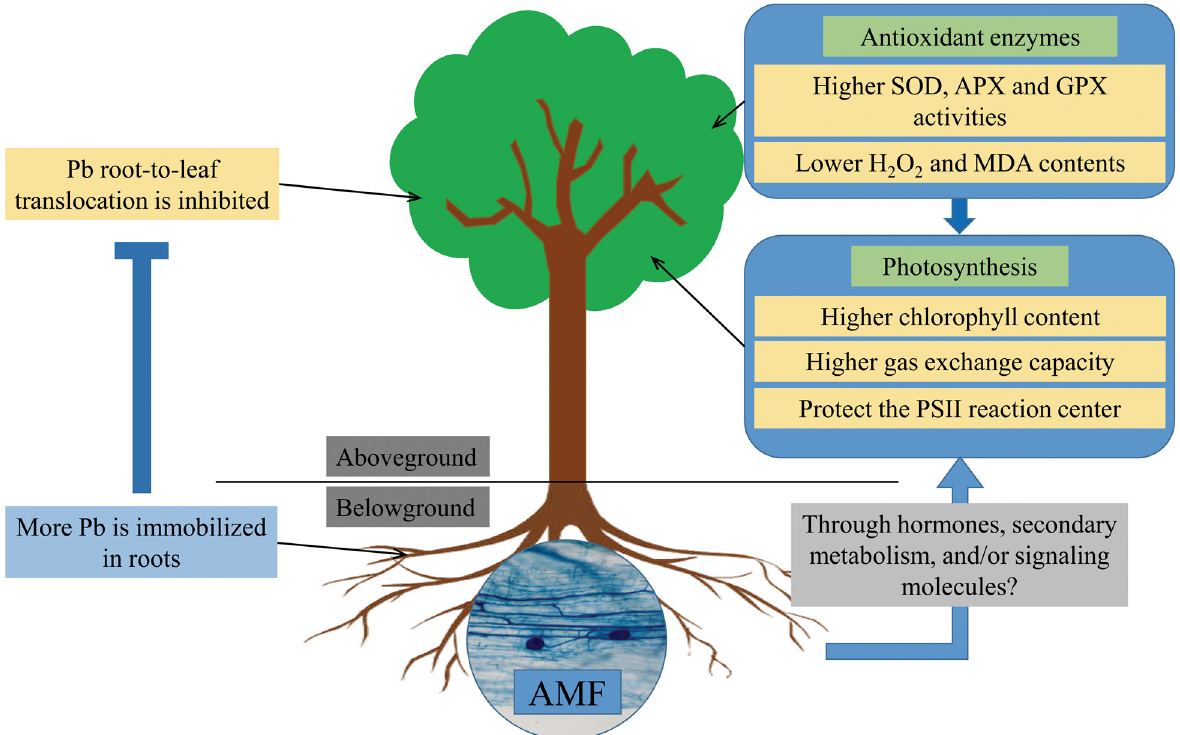
Fig 6. Roles of AMF inoculation in plant tolerance to Pb. AMF inoculation increased root Pb concentration but inhibited Pb root-to-leaf translocation. Mycorrhizal plants had higher leaf SOD, APX and GPX activities but lower leaf H 2 O 2 and MDA contents compared with non-mycorrhizal plants. AMF inoculation increased Chl contents and gas exchange capacity, and protected the PSII reaction center under Pb stress conditions. AMF symbiosis causes physiological changes in plant aerial parts probably through affecting nutritional status, hormonal balance and/or secondary metabolism, and the translocation of small signaling